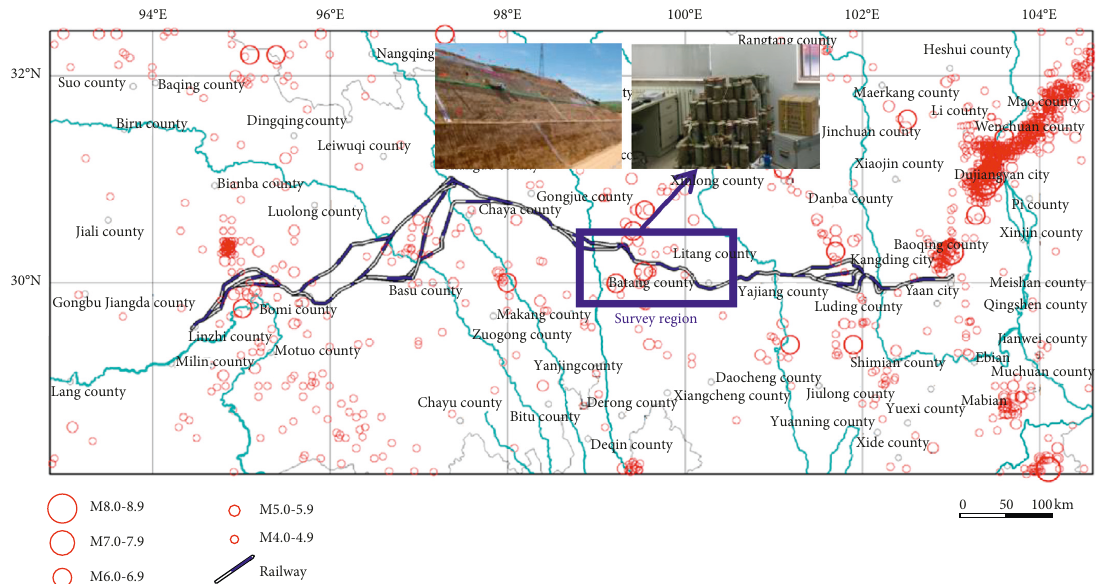
Figure 10: Geographic position of the survey region and seismic epicentral distribution